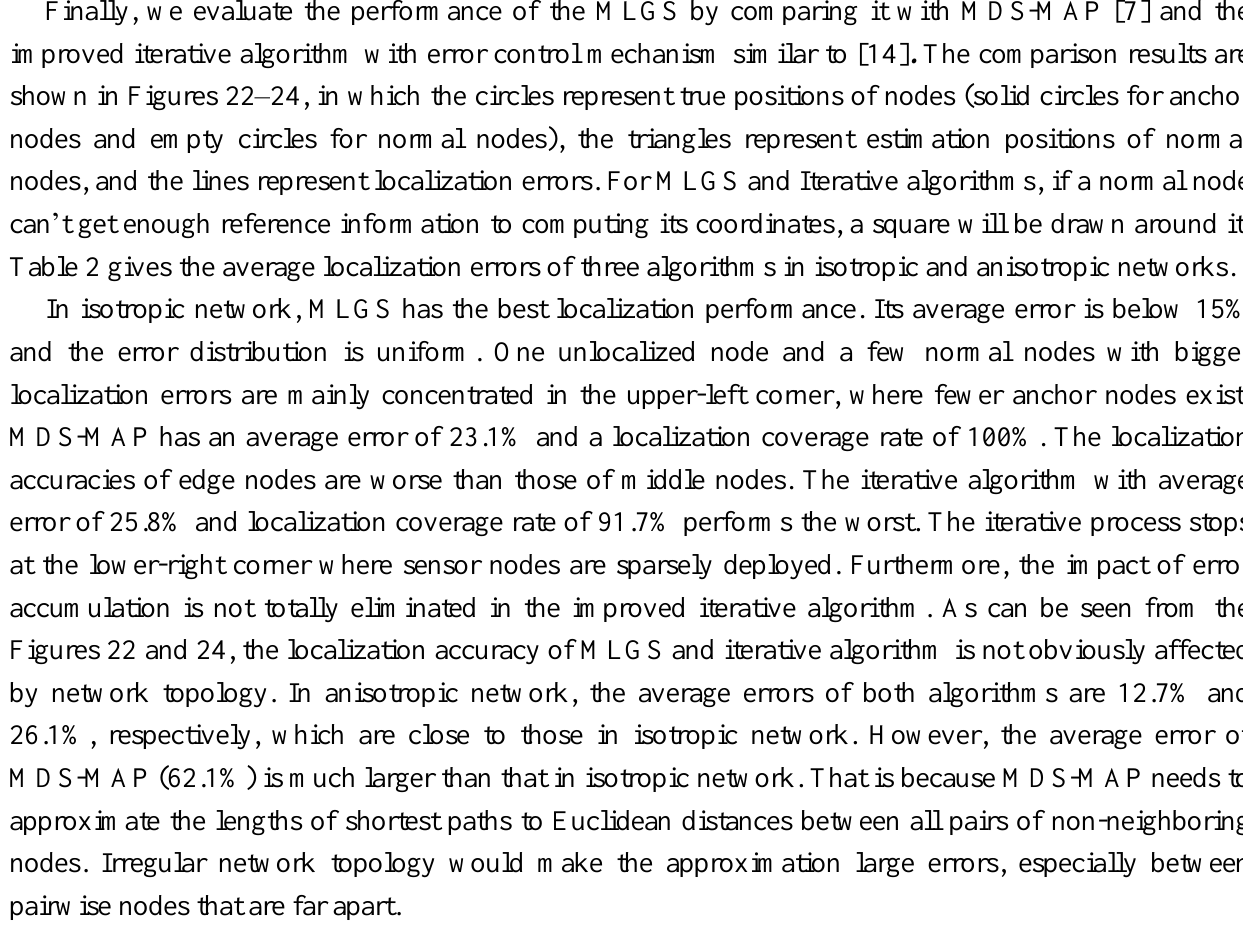
Figure 22. Localization results of MLGS. (a) Isotropic network. (b) Anisotropic